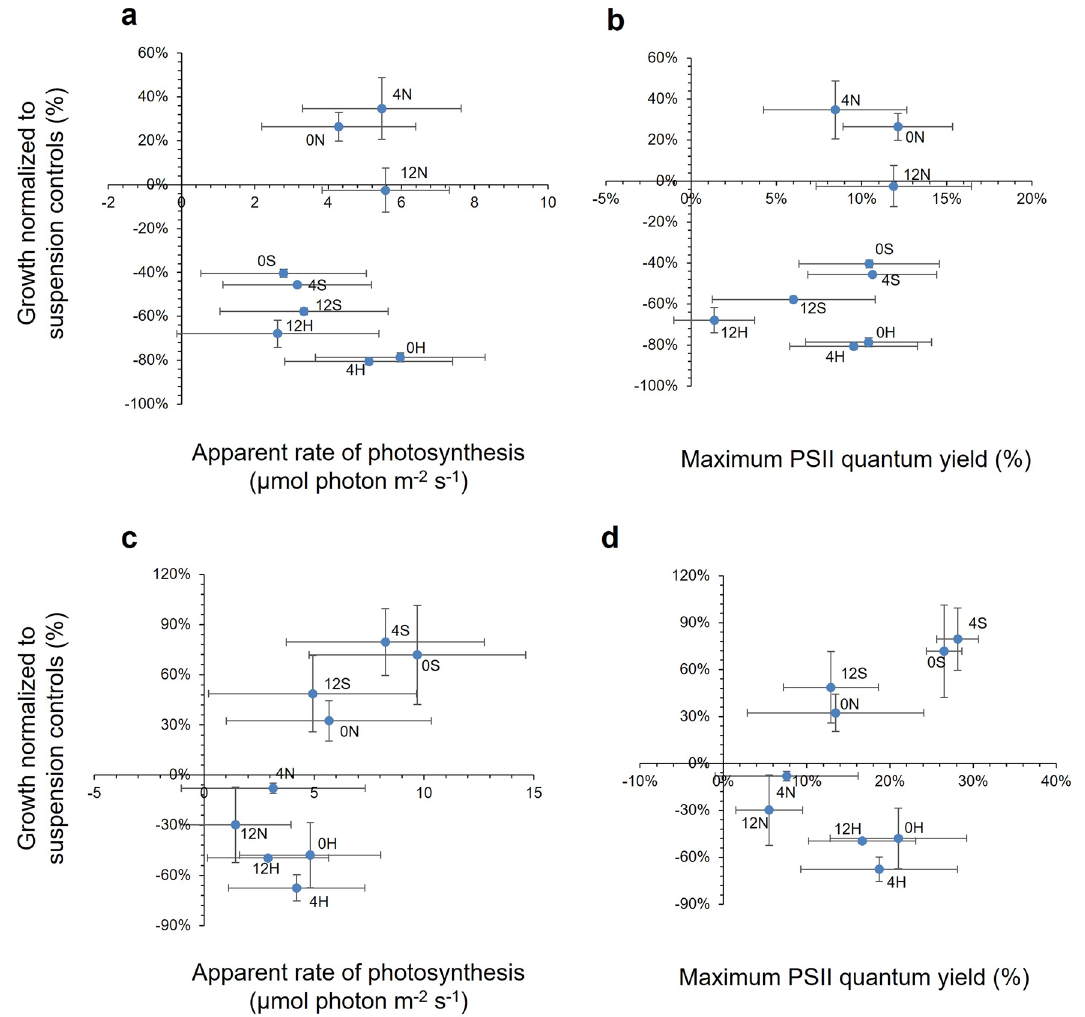
Figure 4. The relationship between growth and photophysiology for Synechococcus elongatus in response to latex formulation. ( a ) Toxicity data plotted against the apparent rate of photosynthesis (PS) and ( b ) the maximum PSII quantum yield (F v /F m ) of PCC 7942. c Toxicity data plotted against PS and d F v /F m of CCAP 1479/1A. ‘Hard’ (H) latex had a styrene to butyl acrylate ratio of 1:3, ‘normal’ (N) was 1:1, and ‘soft’ (S) was 3:1. The preceding number in the latex code corresponds to the Texanol content. (Mean ± StDev; n =